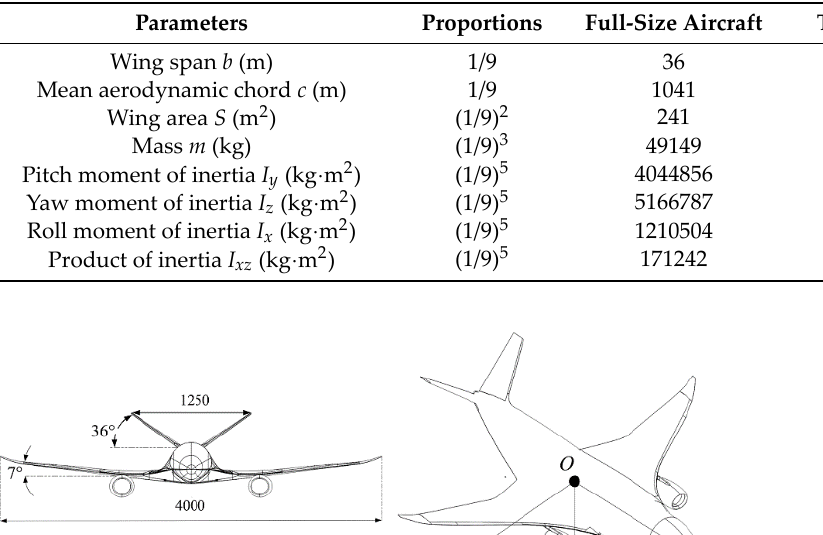
Table 4. Ontology design parameters of the test model.